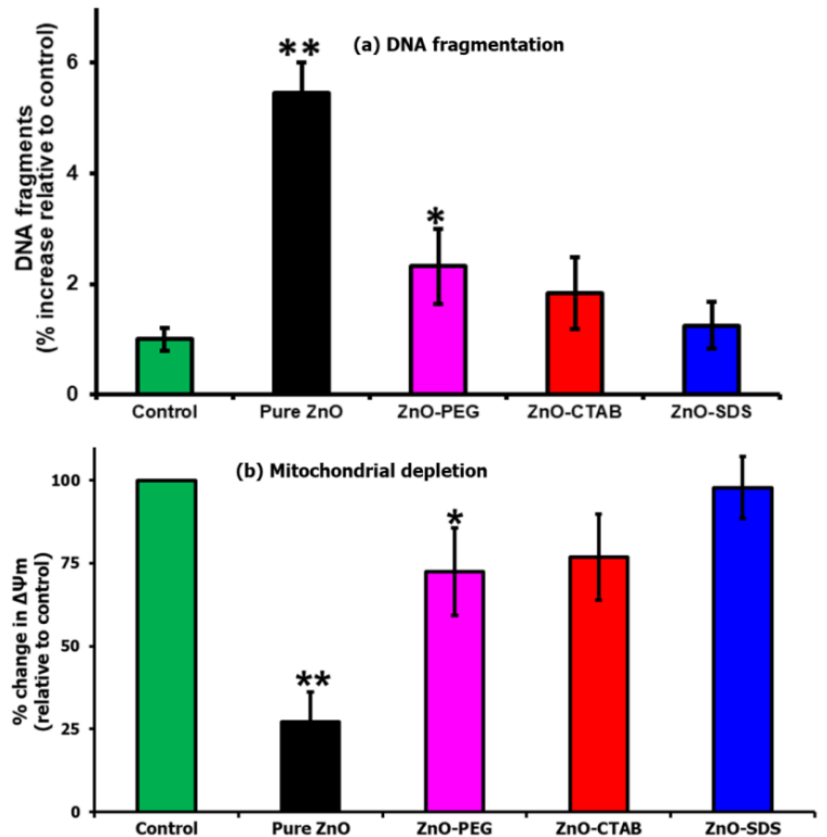
Figure 8. ( a ) DNA fragmentation and ( b ) mitochondrial depletion assay when tested against the four different ZnO NPs (* for significance, p < 0.05, and ** for high significance, p < 0.01 values).